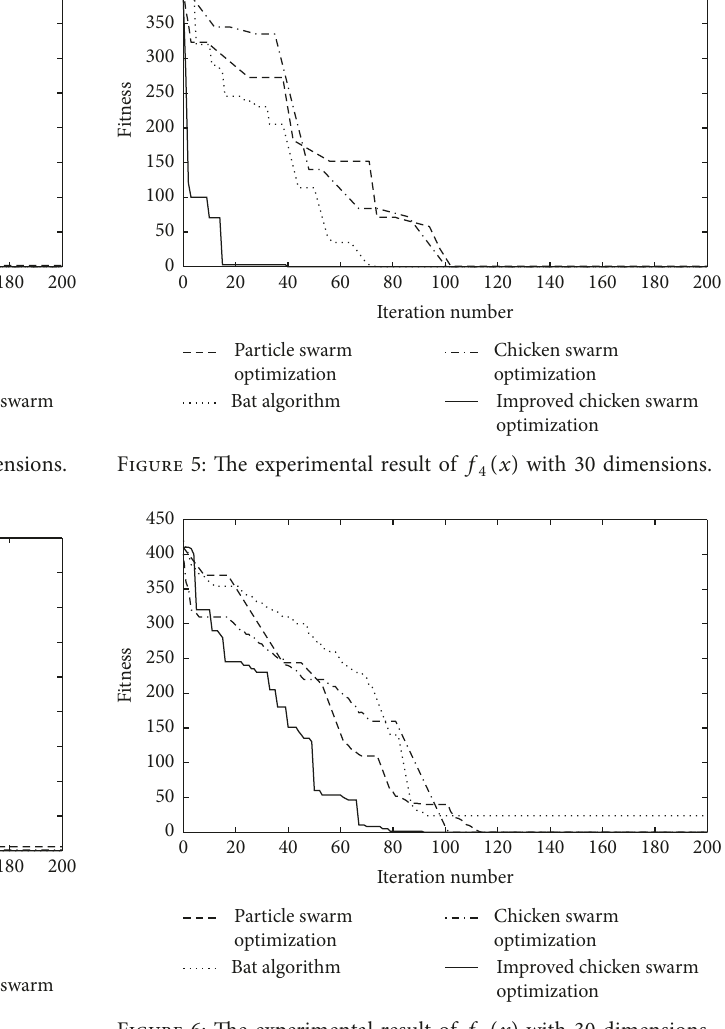
( x ) with 30 dimensions. 5